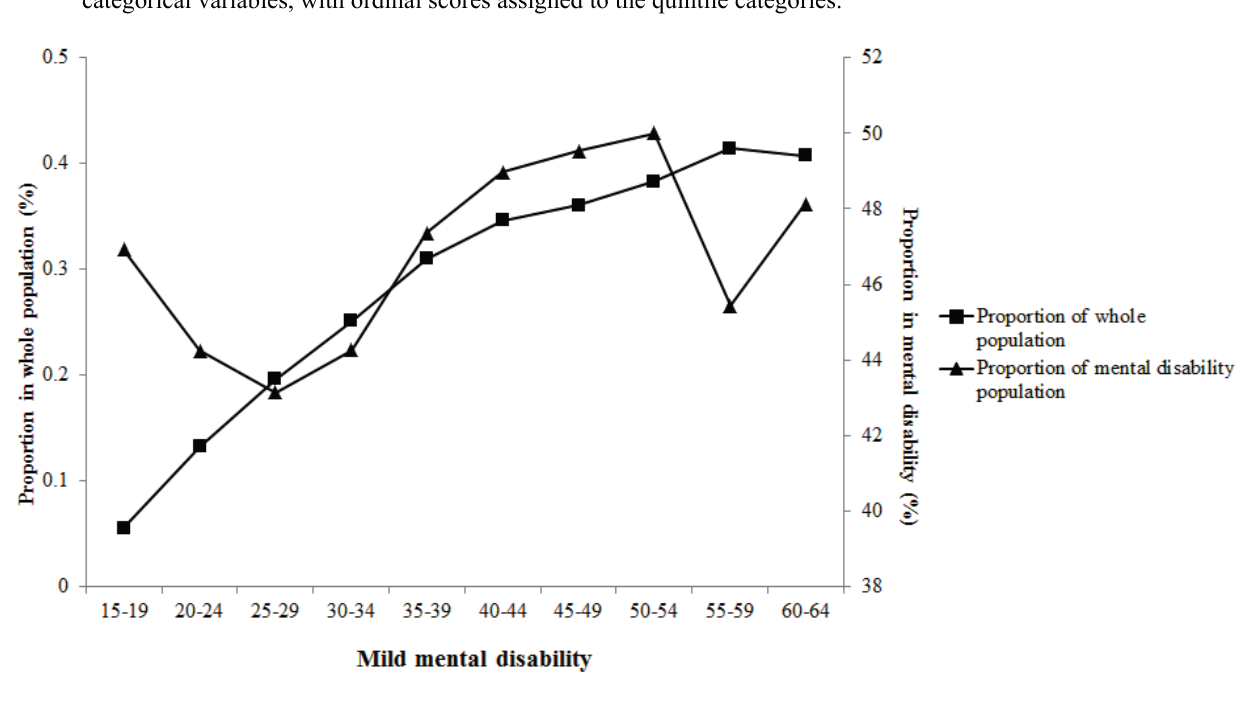
Figure 3. Proportion of mild mental disability in different age